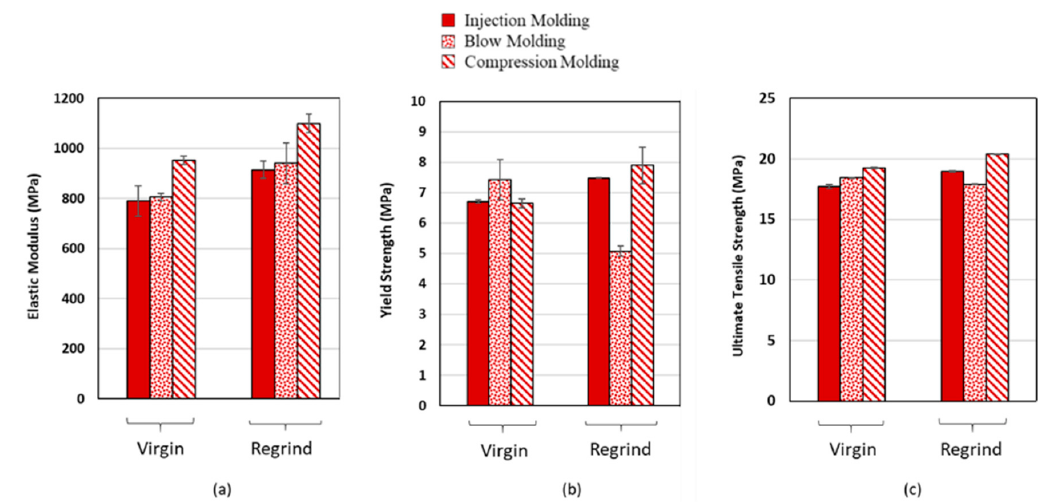
Figure 2. ( a ) Elastic modulus, ( b ) yield strength, and ( c ) ultimate tensile strength for virgin and regrind HDPE, with three processing techniques at RT and 6 × 10 − 4 s − 1 strain rate. Results shown are for average of two tests in each condition.